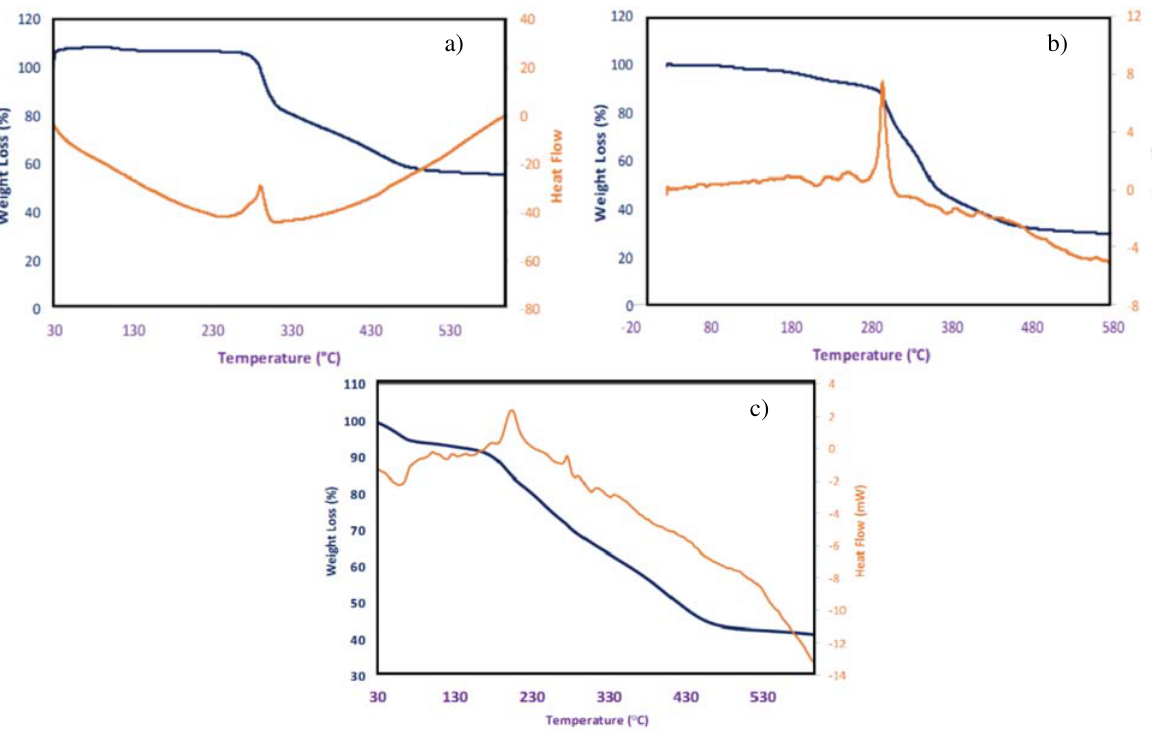
Figure 5. TG and DSC curves of nanofibers (a) PAN, (b) PAN-CLX3 and (c)